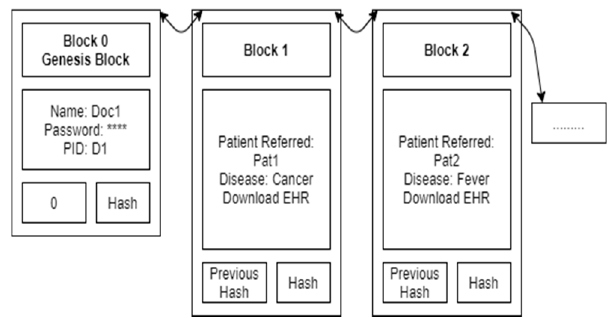
Figure 3. Doctor Doc1 blockchain.